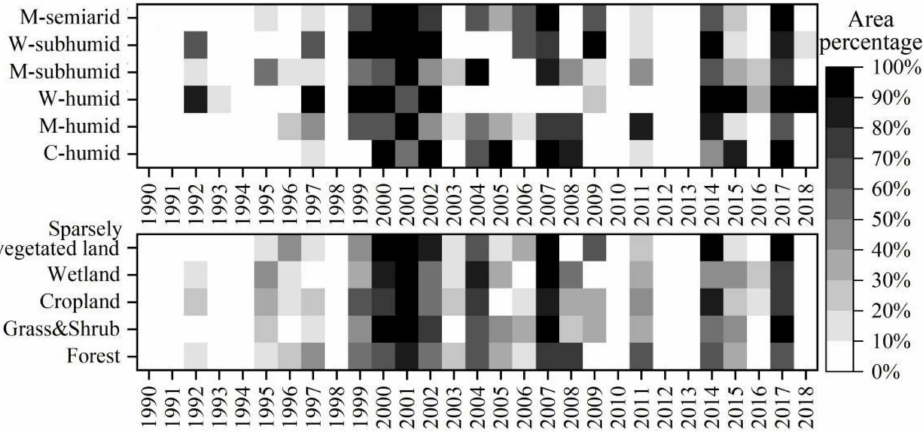
Figure 5. Percentage of annual light drought area (SPEI12 < − 0.5) over different climate regions and land cover types in northeast China (NEC) from 1990 to